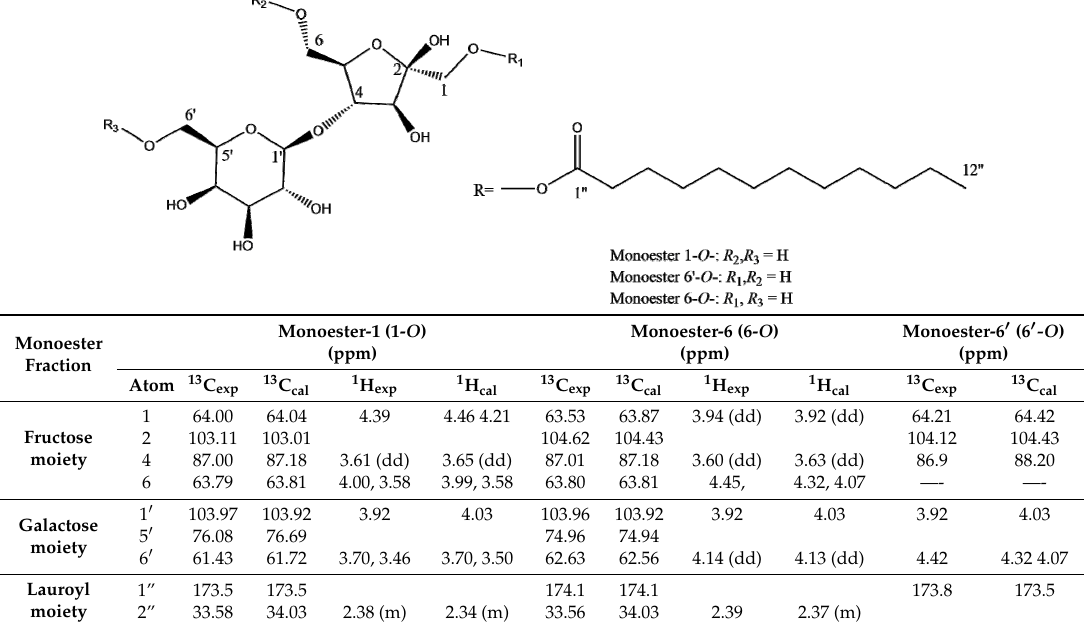
Table 1. Comparative NMR data of the experimental and predicted data of monoesters 1, 6, and 6 (cid:48) . Catalysts 2017 , 7 ,